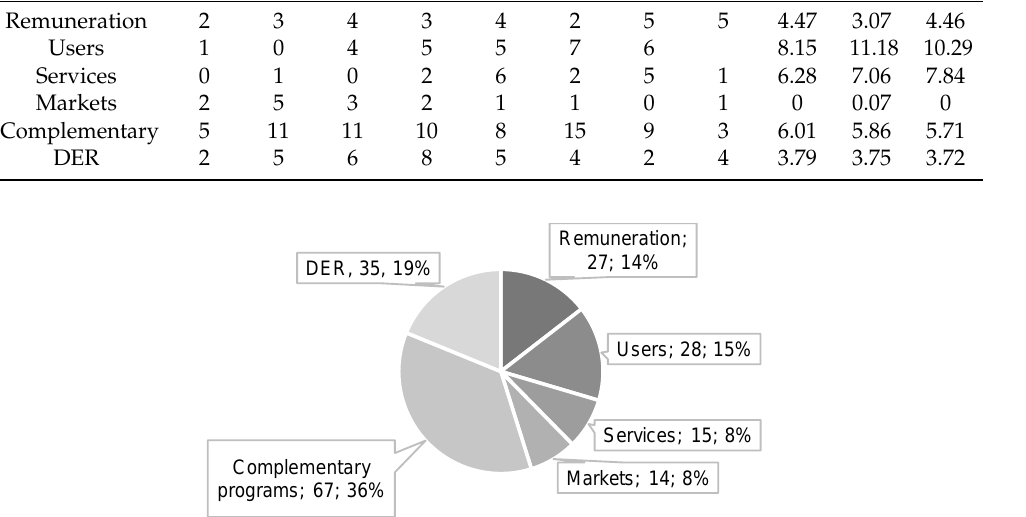
Table 10. Data from the analyzed DR topics used for regression and forecast.